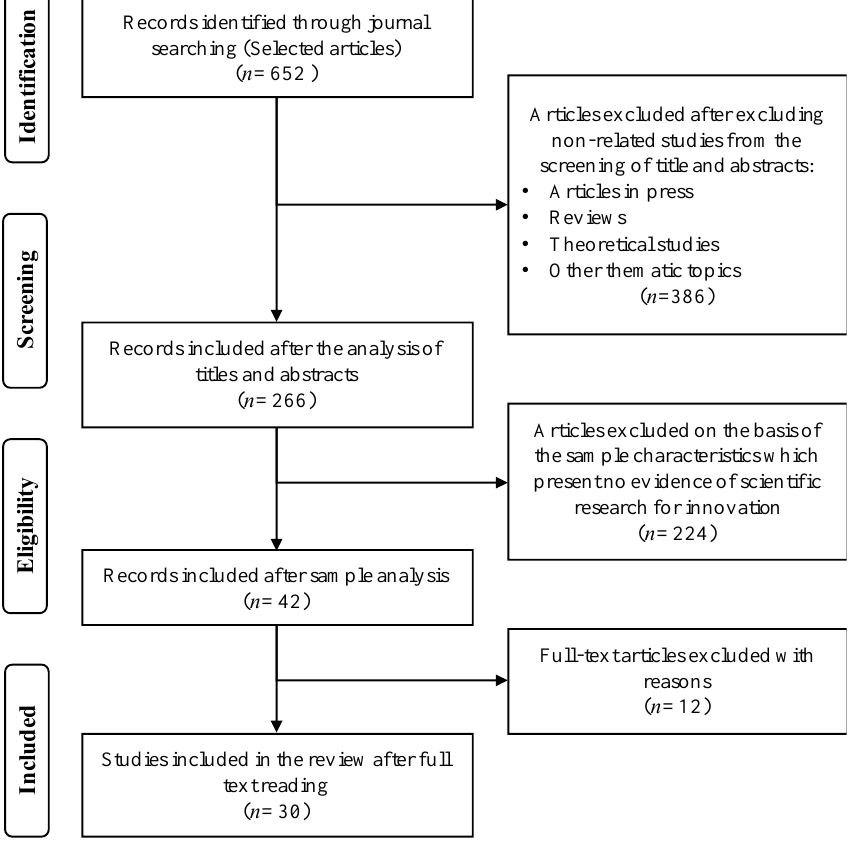
Fig. 1 : PRISMA flow